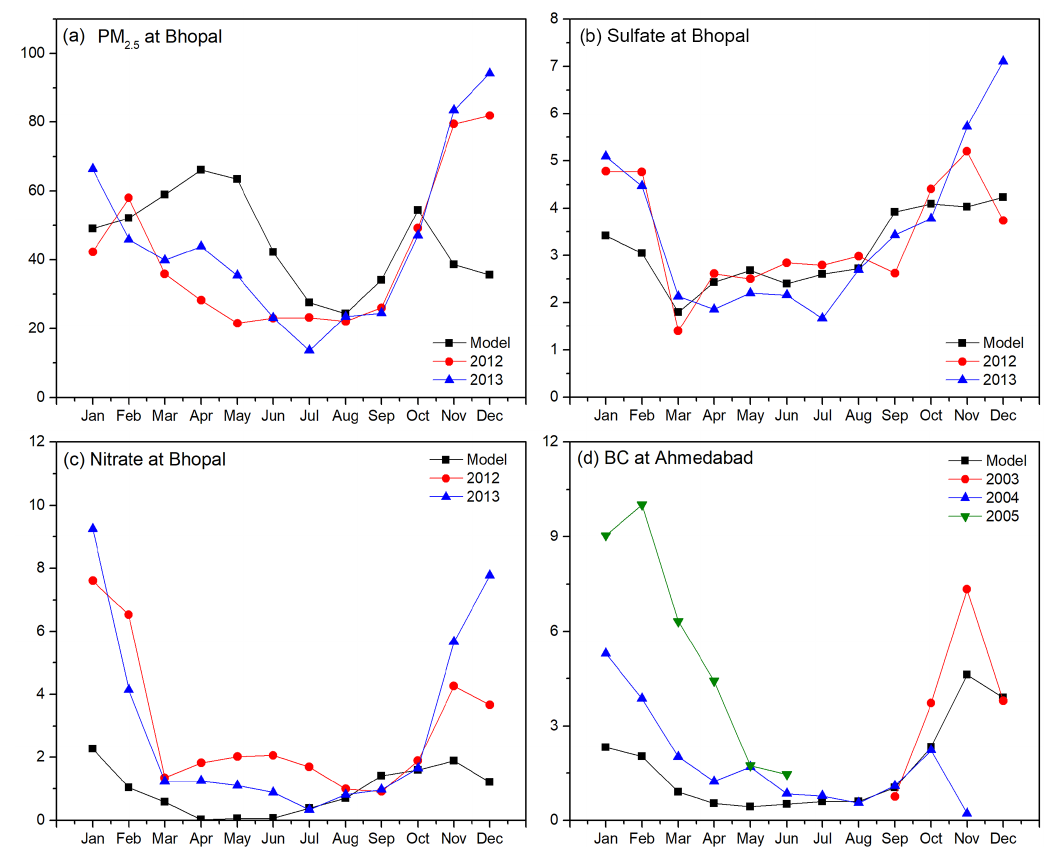
Figure 5. Evaluation of model performance (NMB) in capturing seasonal variation in chemical species concentrations at two sites in India.